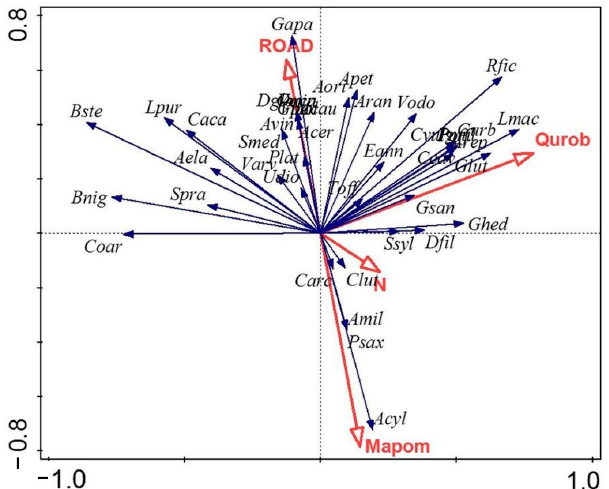
Figure 5. The redundancy analysis shows the impact of common oak (Qurob), Osage orange (Mapom), and former chariot roads (ROAD) on the herbaceous species composition of shelterbelts, while other factors (e.g., N) are not significant.